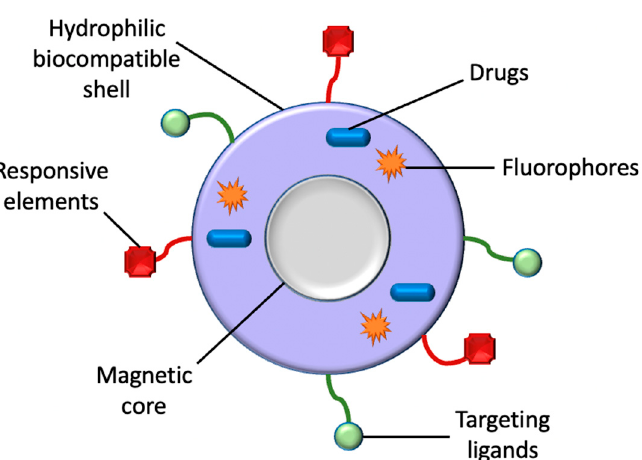
Figure 2. A classic illustration of a magnetic nanoparticle’s structure. Aside from drugs, MNPs can also be utilized for the transportation of targeting ligands, fluorophores, and responsive elements for their respective biomedical applications.